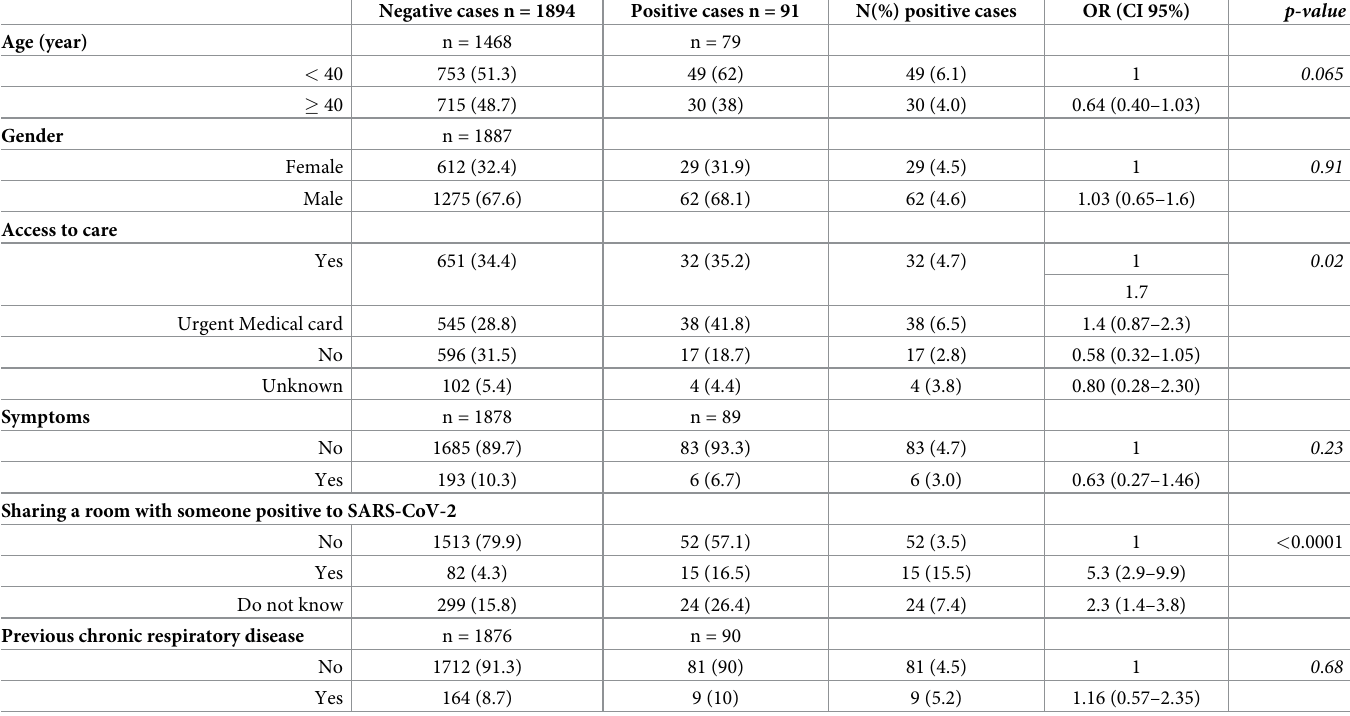
Table 2. Risk factors of